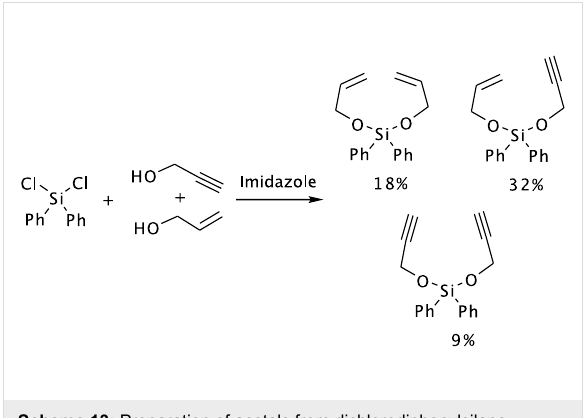
Scheme 13: Preparation of acetals from